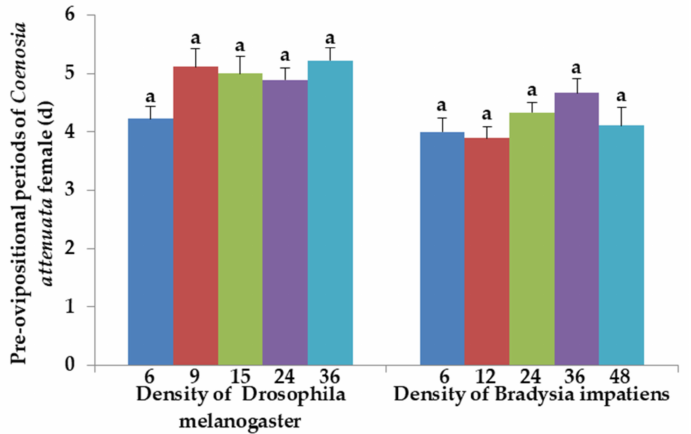
Figure 4. Preovipositional periods of C. attenuata female adult when fed 6, 9, 15, 24 and 36 adults of D. melanogaster and 6, 12, 24, 36 and 48 adults of B. impatiens daily per predator adult. Different letters above each bar indicate significant differences between prey densities using one-way ANOVA, Tukey’s HSD test ( p = 0.05 and n = 9).